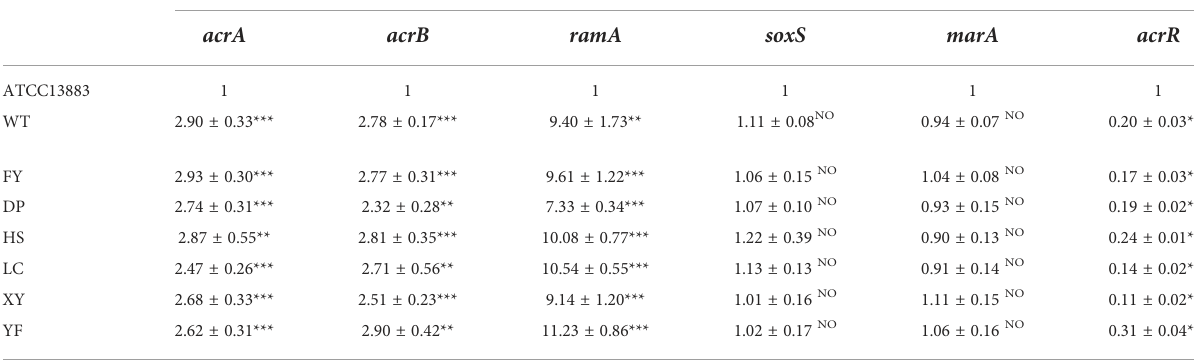
TABLE 3 Expression of acrA , acrB , ramA , soxS , marA , acrR of seven XDR-HvKp strains. Isolation